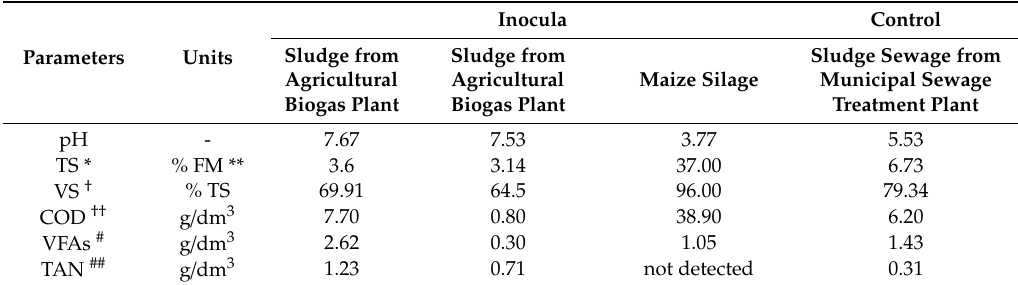
Table 1. Characteristics of the inoculum and substrate used in the experiment.